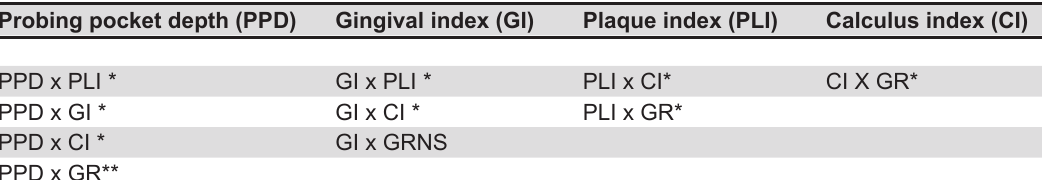
Table 3- Results of the study of correlations among clinical parameters from 6 sites of the entire dentition in CRF and control groups by Spearman test (p<0.05)